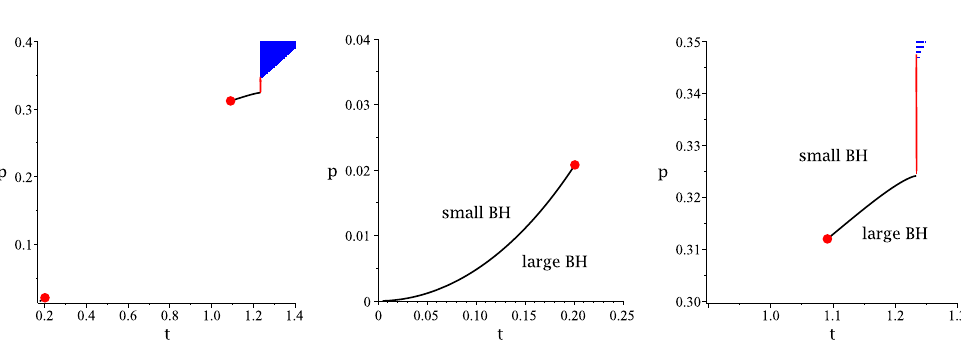
Figure 5 . Phase diagram for k = +1 , (cid:15) = (cid:0) 1 , (cid:11) = (cid:0) 0 : 6 , h = (cid:0) 5 and q = 0 : Left : the full phase diagram. Center : a zoomed-in view of the lower-left portion of the phase diagram, showing VdW behaviour. Right : a zoomed-in version of the upper-right portion of the phase diagram, showing zeroth and (cid:12)rst order phase transitions. The large red circles correspond to critical points, the solid black line is the coexistence line of a (cid:12)rst order phase transition, and the solid red line marks a zeroth order phase transition. In the blue shaded region, no black hole solutions exist.